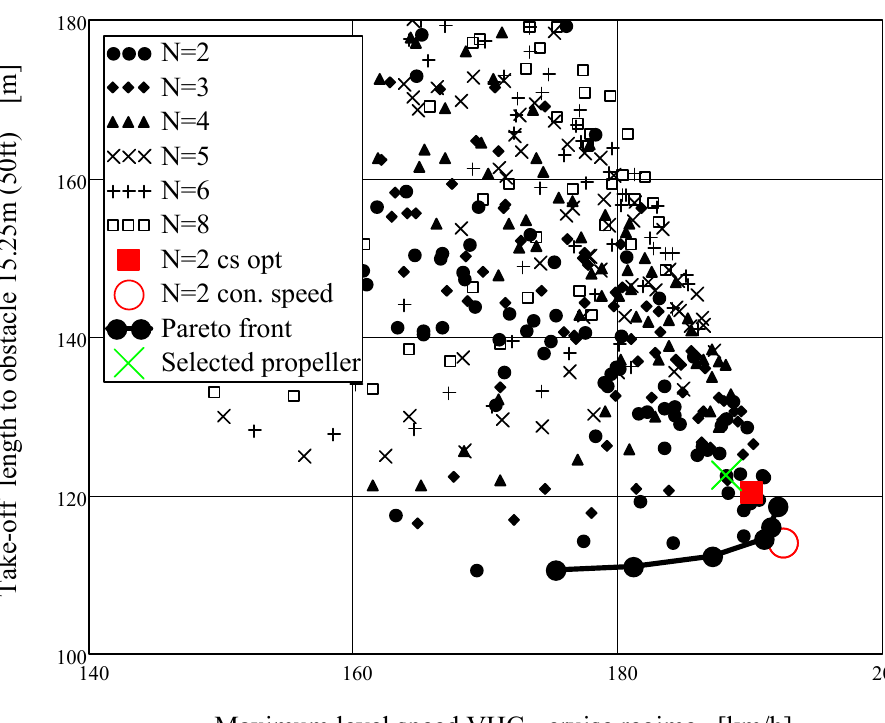
Aerospace 2019 , 6 , x FOR PEER REVIEW maximal, i.e., optimal solutions are in the top right-hand part of the graph. Like before, optimal solution obtained by means of speed power coefficient is part of optimal set only for the case of the maximal continuous engine power. Figure 7. Pareto frontier for maximum horizontal flight speed (cruise engine regime)–take-off distance. Table 2. Points on the Pareto front for maximum horizontal speed (continuous engine regime) and take-off length (see Figure 7).